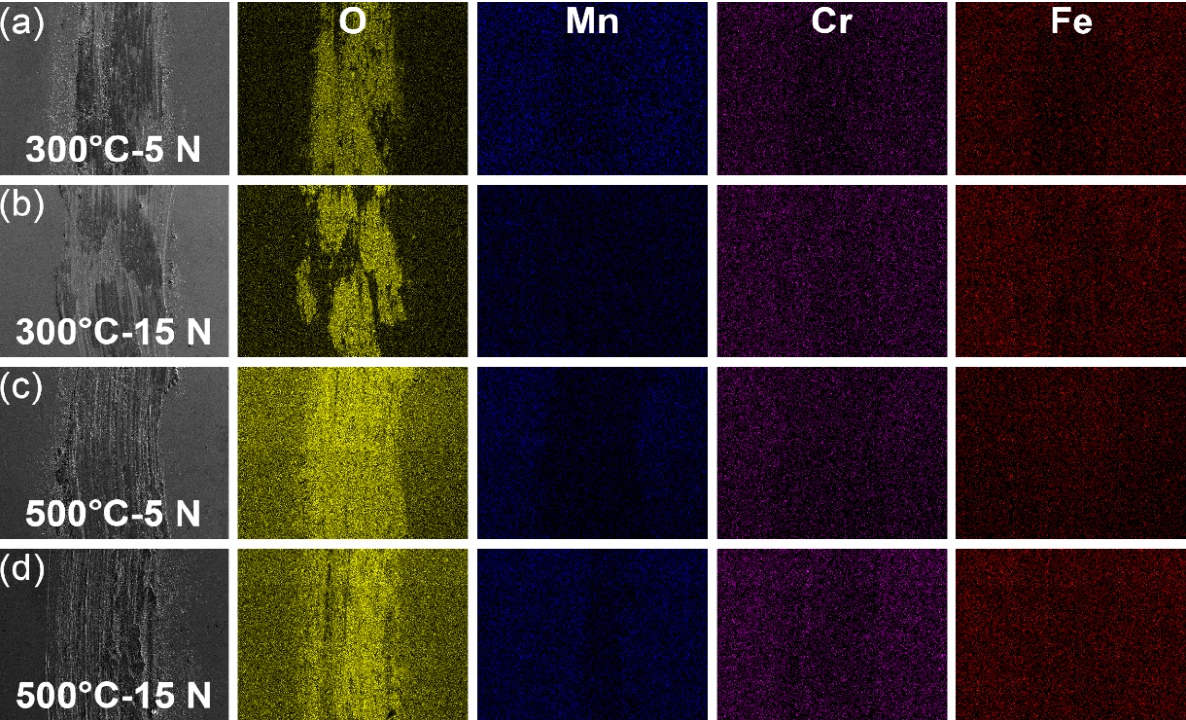
Figure 5. SEM morphologies of worn surfaces and corresponding element mapping: ( a ) 300 °C–5 N, ( b ) 300 °C–15 N, ( c ) 500 °C–5 N, and ( d ) 500 °C–15 N.